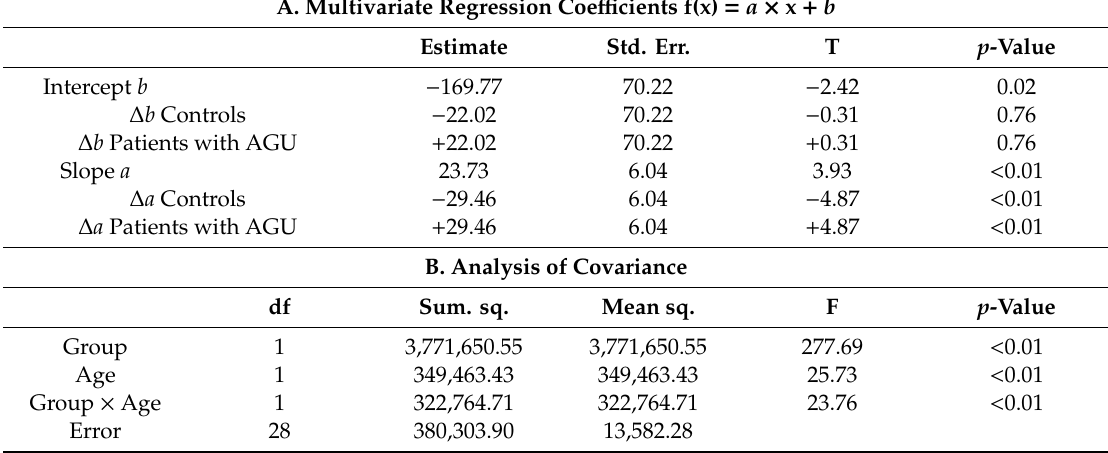
Table 2. The iron accumulation region test results between age and average image intensity. A. Multivariate Regression Coe ffi cients f(x) = a × x + b Estimate Std.